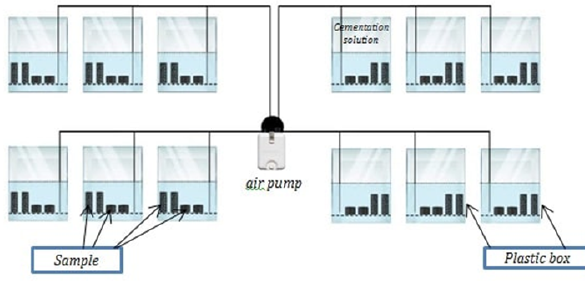
Figure 2: Schematic drawing for the treatment